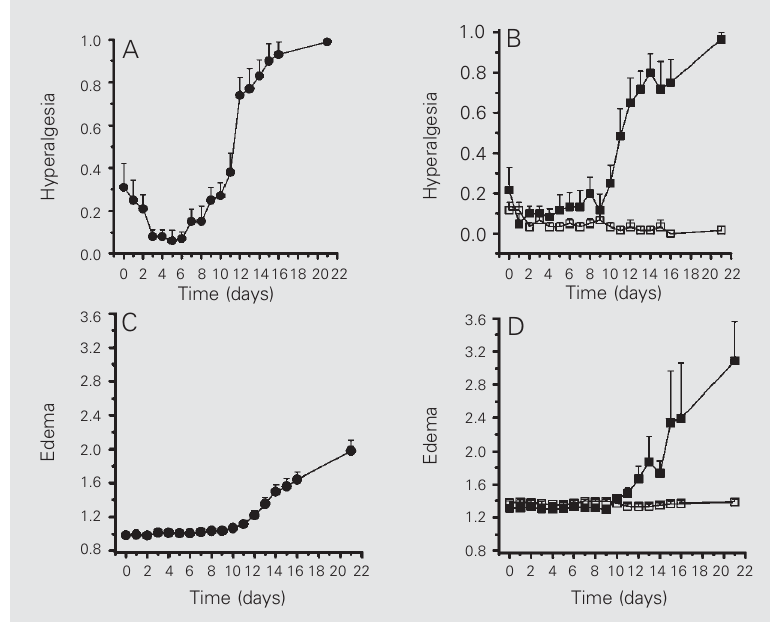
Figure 1. Development of hyperalgesia (A, B) and paw edema (C, D) following the induction of arthritis in juvenile (N = 10, circles), old responder (N = 3, open squares) and old nonresponder (N = 9, filled squares) rats. Arthritis was induced at day zero by subcutane- ous injection of 0.2 ml of an emulsion containing 400 µg Mycobacterium butyricum into the base of the rat tail. Hyperalgesia (A, B) is reported as the mean number of vocalizations (± SEM) in response to 5 flexions of the tarsotibial joints assessed daily. Old responder animals (filled squares, 6 of 12) presented the same profile of hyperalgesia as juvenile animals. Data for nonresponder animals (open squares) are also shown. Edema (C, D) is reported as the mean increase in volume ± SEM (in ml) found for both hind paws, also assessed daily. Old responder rats presented more intense paw edema on the 21st day of observation compared with juvenile animals (compare D with C) and more interindividual